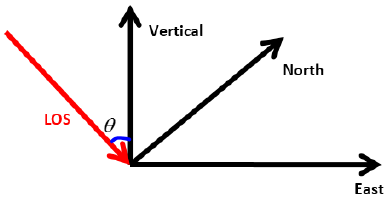
Figure 7. Monitoring Result Direction Difference between InSAR (LOS direction) and leveling task (vertical direction) for the reason of SAR side ‐ look geometry. (vertical direction) for the reason of SAR side-look geometry.